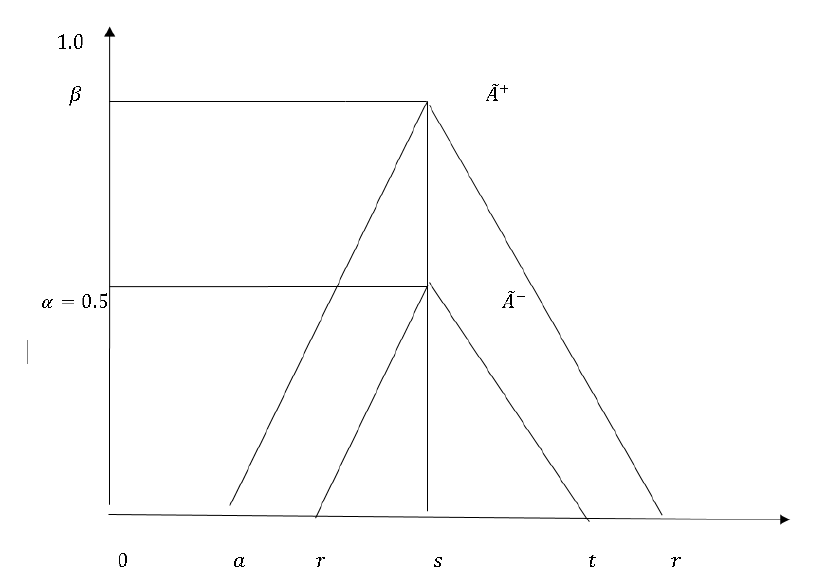
Fig. 2. Level (𝛄, 𝛅) interval- valued fuzzy